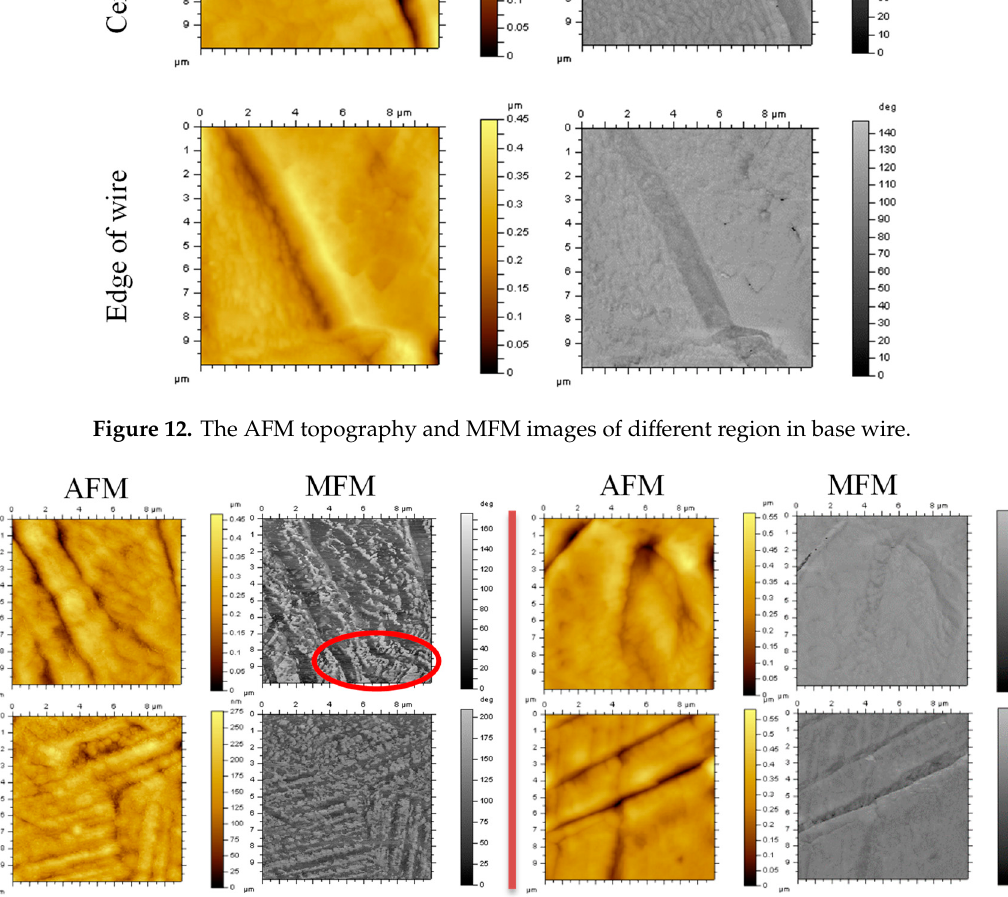
Figure 13. The AFM topography and MFM images of the 1st drawn wires.